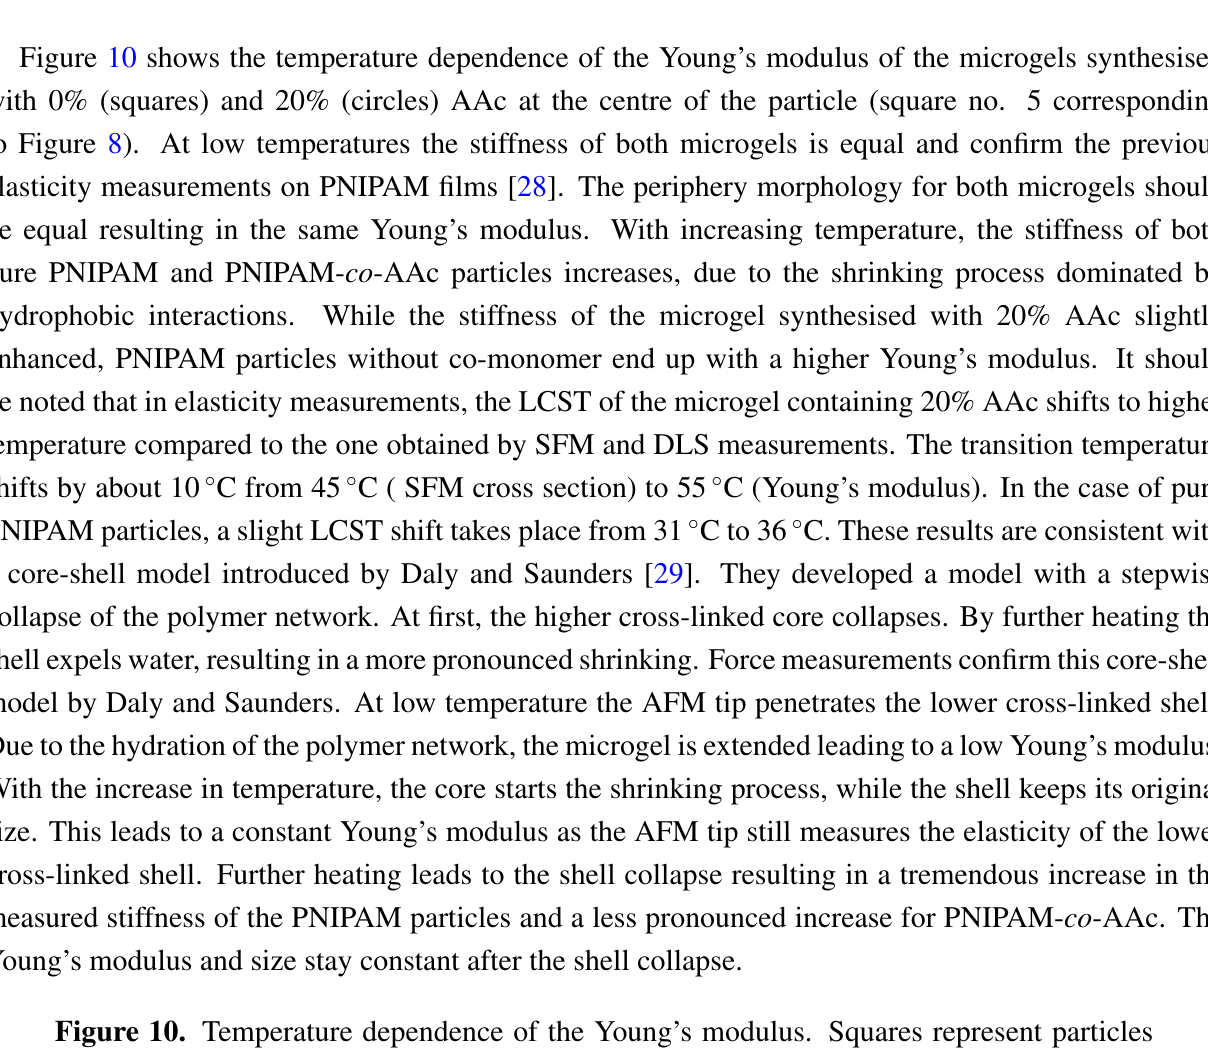
Figure 10. Temperature dependence of the Young’s modulus. Squares represent particles without co-monomer, circles represent the microgel with 20% AAc. Young’s